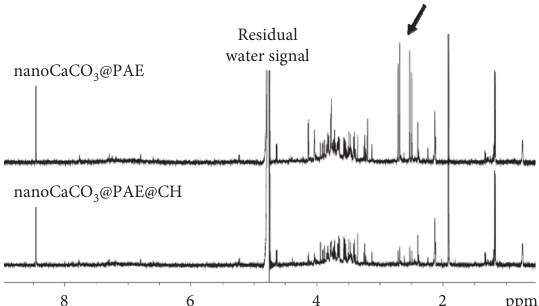
Figure 6: 1 H zgcppr NMR spectra of released PAE from nanoCaCO indicated by black